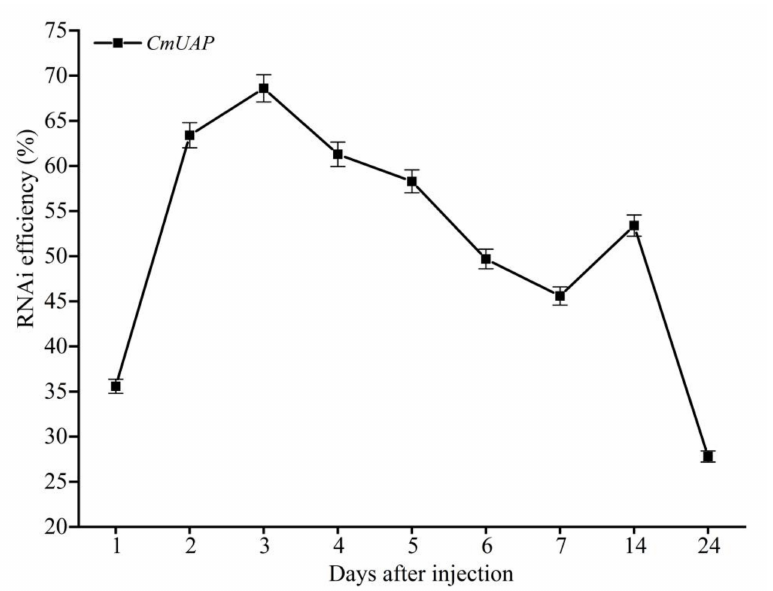
Figure 7. RNAi efficiency at different times. 1–7, RNAi effect on larvae 1–7 days post injection; 14,